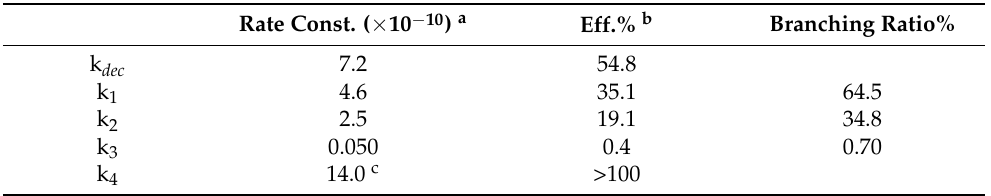
Figure 3. Kinetic plots and best fit lines of the reaction of isolated HCO 4 − ions ( m/z 77) (P SO 2 = 1.97 × 10 − 7 Torr): ● HCO 4 − (R 2 = 0.9997), ■ HSO 4 − (R 2 = 0.9989); ▲ HSO 3 − (R 2 = 0.9946); ♦ HCO 3 − (R 2 = 0.9941); x SO 3 − (R 2 = 0.9764). Table 1. Rate constants (cm 3 s − 1 molecule − 1 ), efficiencies (%), and branching ratios (% Σ ) relative to the reaction of HCO 4 − + SO 2 . See text for rate constant numbering, k n .